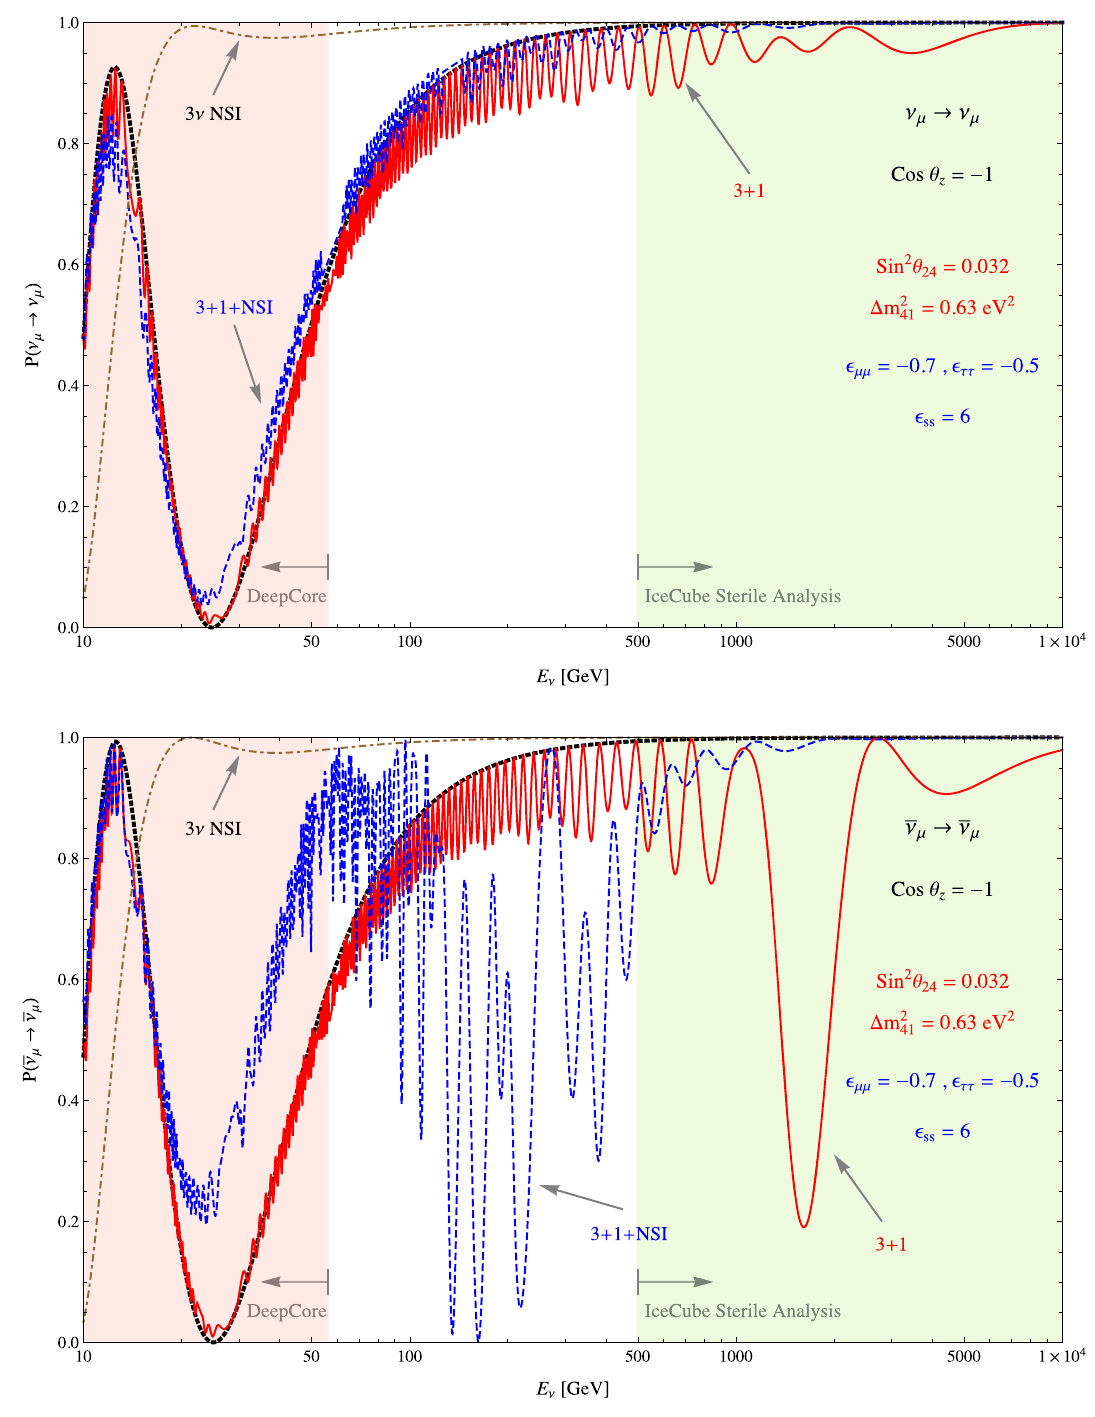
Fig. 4 The same as in Fig. 2 but for the case (b) shown in Table 1 N 0 is the number of events in the 3 ν scenario in the i th i , j bin of energy and j th bin of cos θ z , which can be calculated by convoluting the effective area with the neutrino flux and oscillation probability. The N i , j is the number of events in the ( 3 + 1 ) + NSI scenario with the sterile mixing parameters